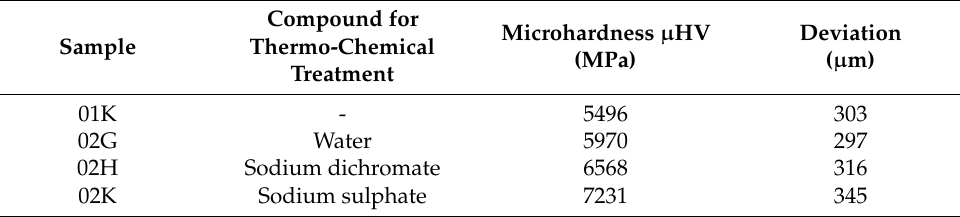
Table 5. Influence of thermo-chemical treatment on value of microhardness of Al 2 O 3 layers.